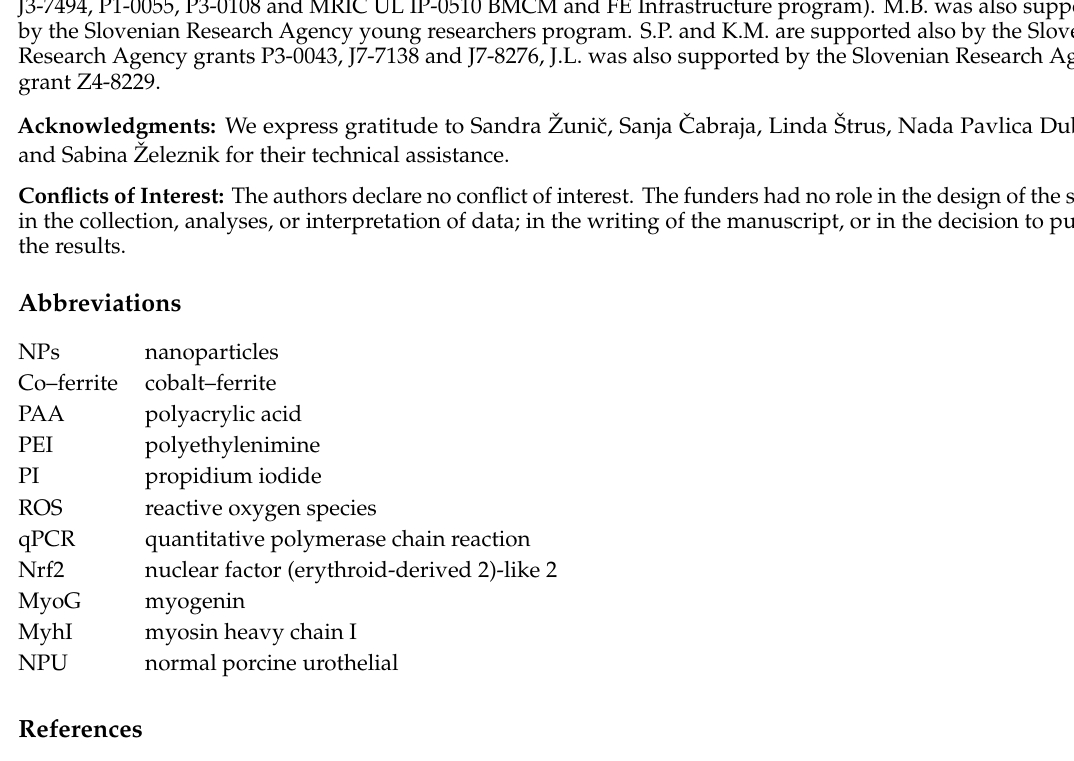
Figure S1: TEM micrographs of NPs dispersed in water, Figure S2: Number size distributions of NPs in distilled water, MEMa and UroM